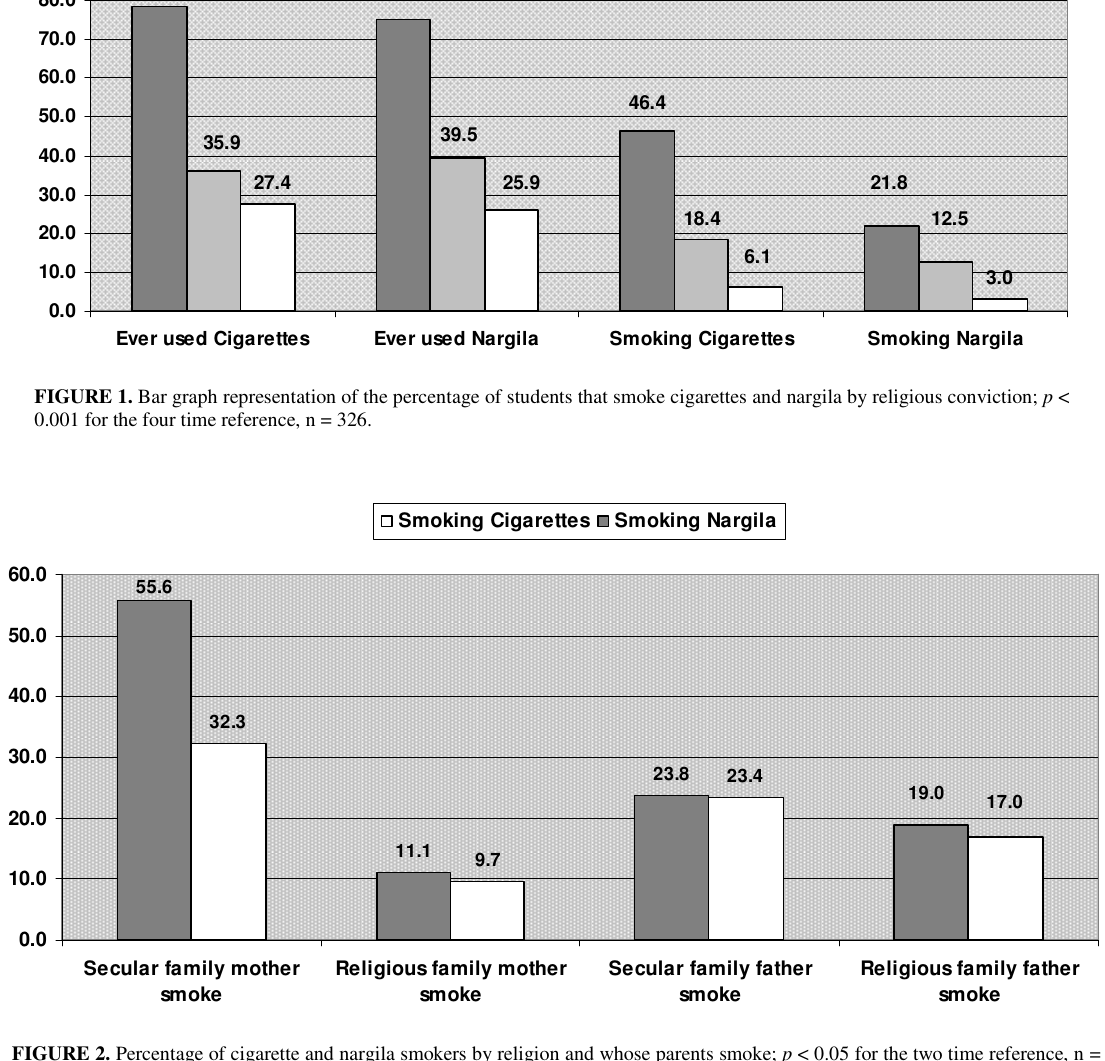
FIGURE 2. Percentage of cigarette and nargila smokers by religion and whose parents smoke; p < 0.05 for the two time reference, n =